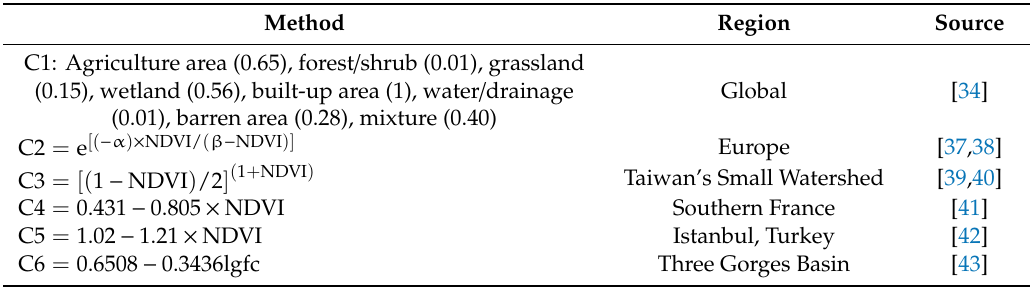
Table 2. Cover management factor (C factor) estimation methods. Method Region